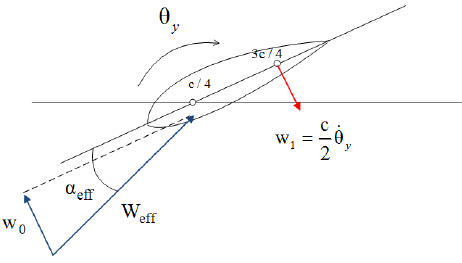
Figure 8. Local velocity components of the ONERA